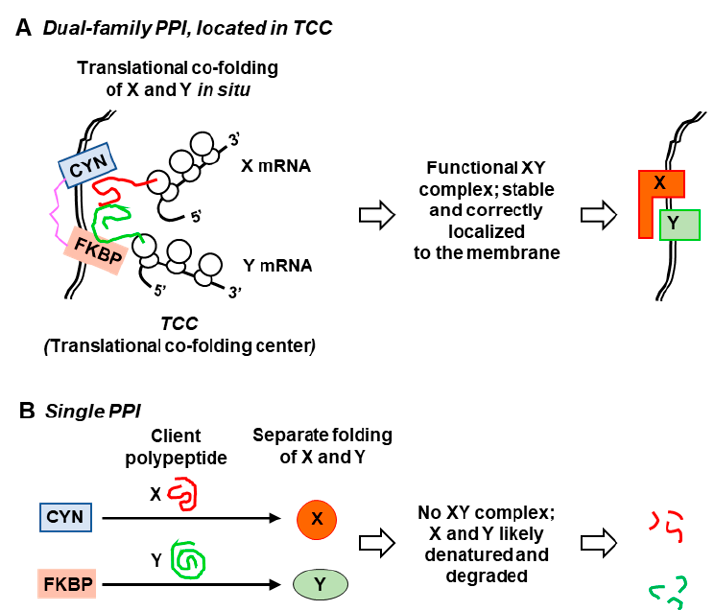
Figure 4. Proposed model for co-folding of multiple polypeptides by dual-family peptidylprolyl isomerase (PPI) in a “translational co-folding center” (TCC). The domain color codes are the same as in Figures 2 and 3: CYN, cyan; linker, pink; FKBP, salmon. In this model, ( A ) the assembly of specific multisubunit complexes is facilitated by joint folding (co-folding) of multiple nascent subunits (X and Y, in red and green, respectively) in situ. It is efficiently achieved by the DFPPI, localized in strategic places, such as cellular or organellar membranes (shown as a double line). Polyribosomes translating